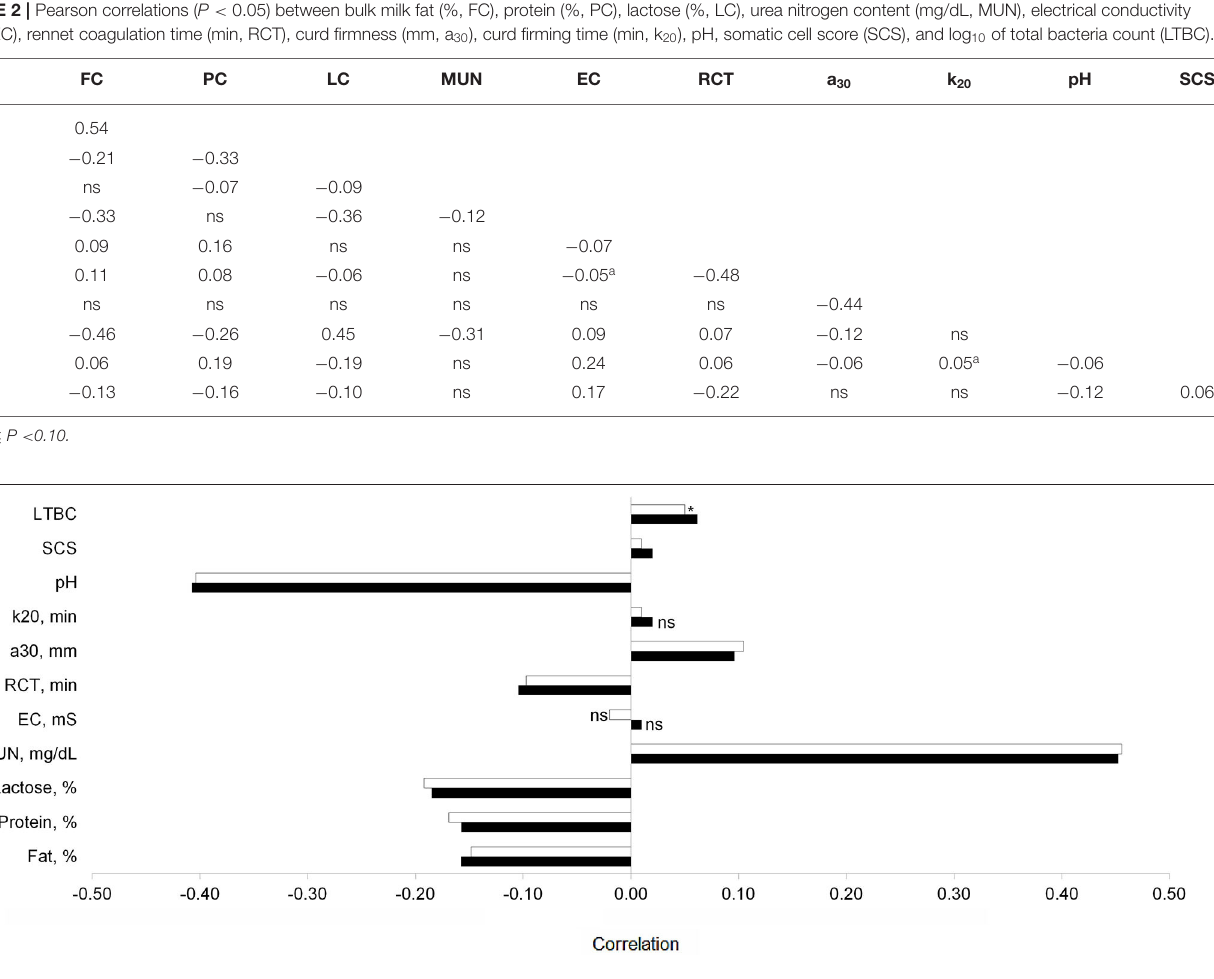
FIGURE 3 | Pearson correlations ( P < 0.05) of temperature-humidity index (black bar) and maximum temperature-humidity index (white bar) with milk composition traits, urea nitrogen (MUN), electrical conductivity (EC), rennet coagulation time (RCT), curd firmness (a 30 ), curd firming time (k 20 ), somatic cell score (SCS), and log 10 of total bacteria count (LTBC). Asterisk indicates 0.05 ≤ P <